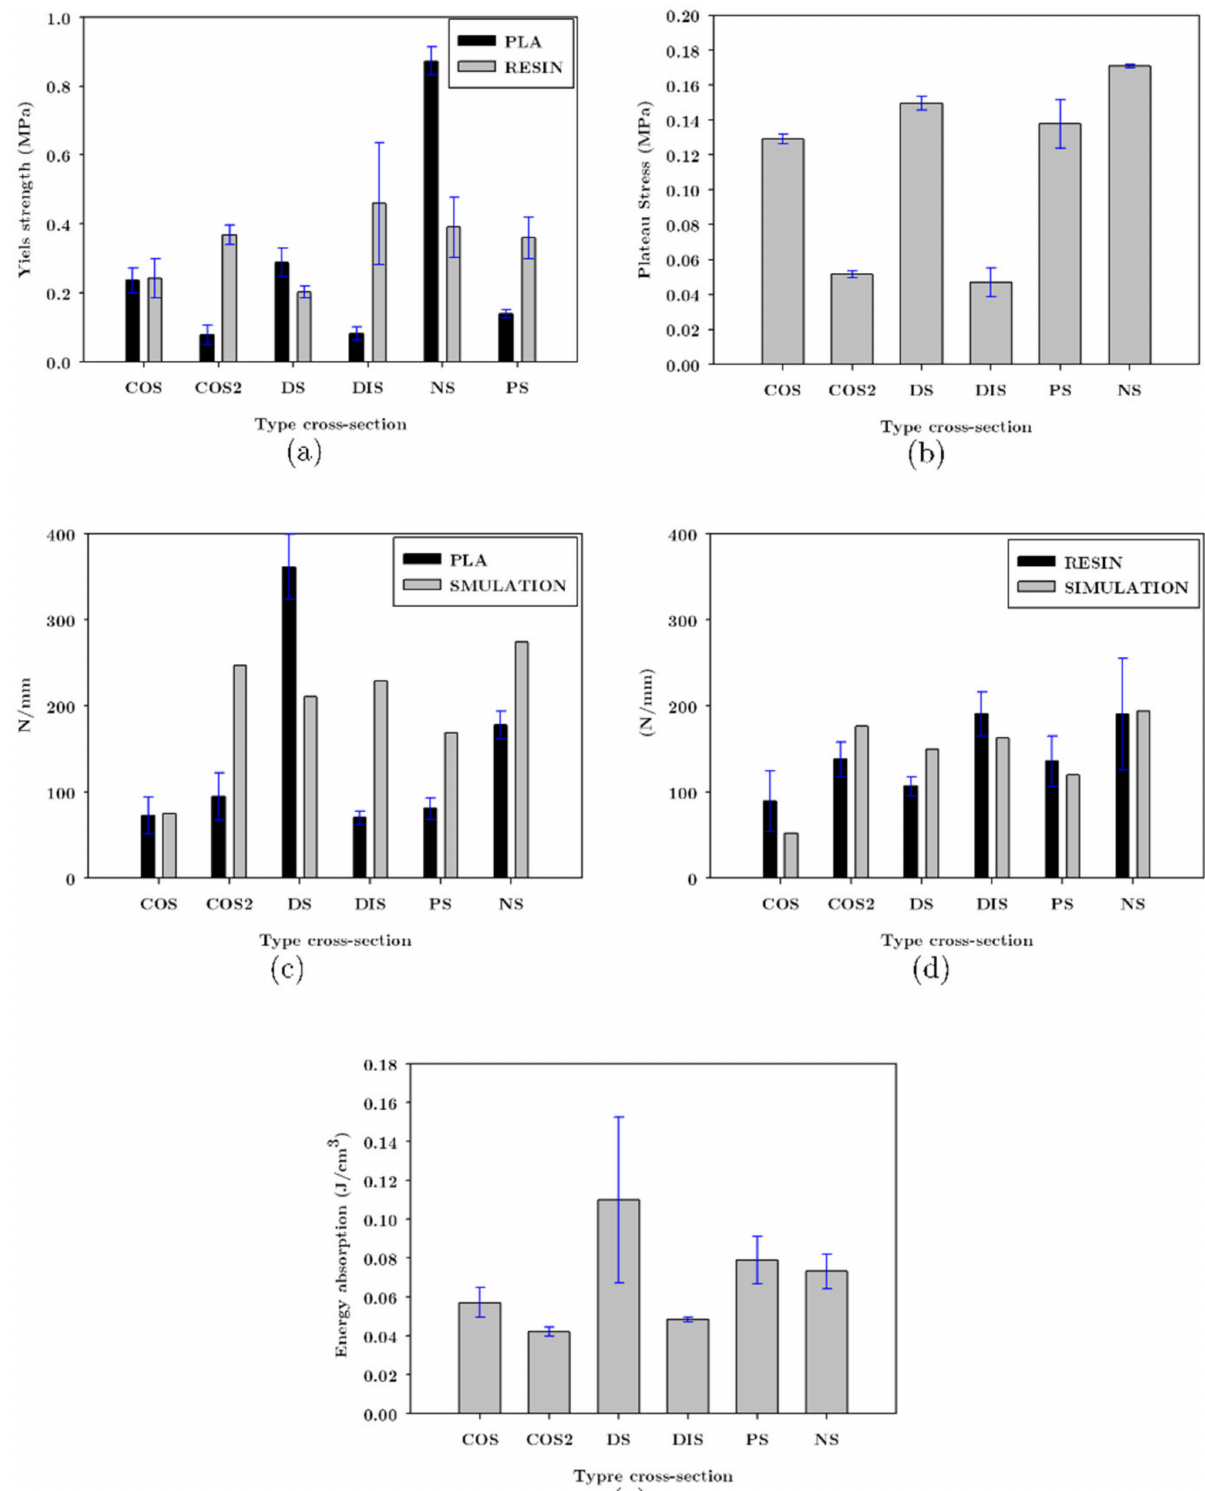
Figure 19. Comparative mechanical properties graph between lattices structures UPLS manufactured ( a ) Yield strength, ( b ) Plateau stress, ( c ) Stiffness comparative between experimental FFF and FEA, ( d ) Stiffness comparative between experimental LCD and FEA, and ( e ) Energy absorption of PLA lattice